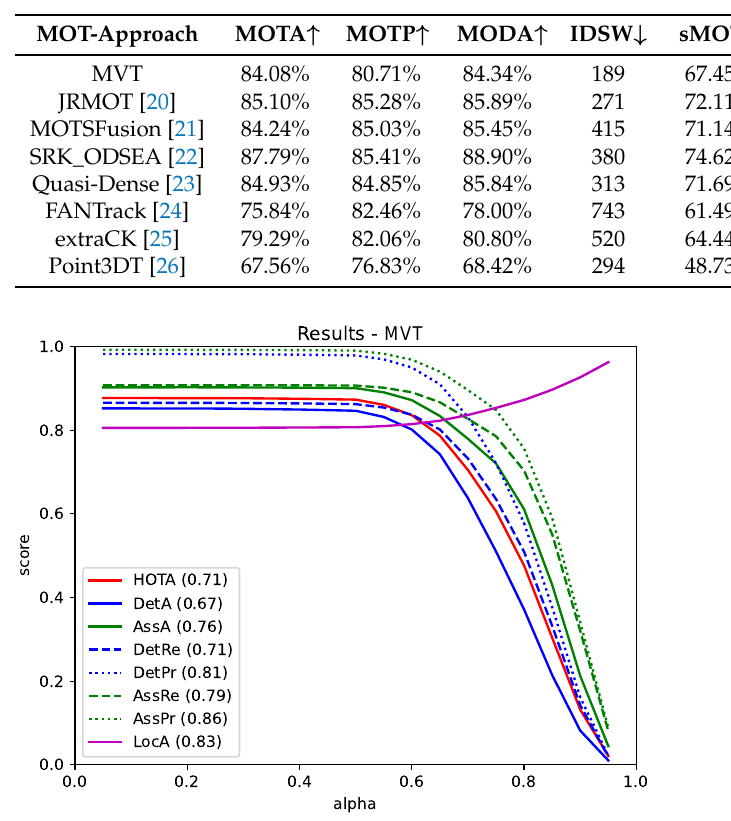
Table 3. Comparison results of several algorithms for seven metrics such as MOTA.